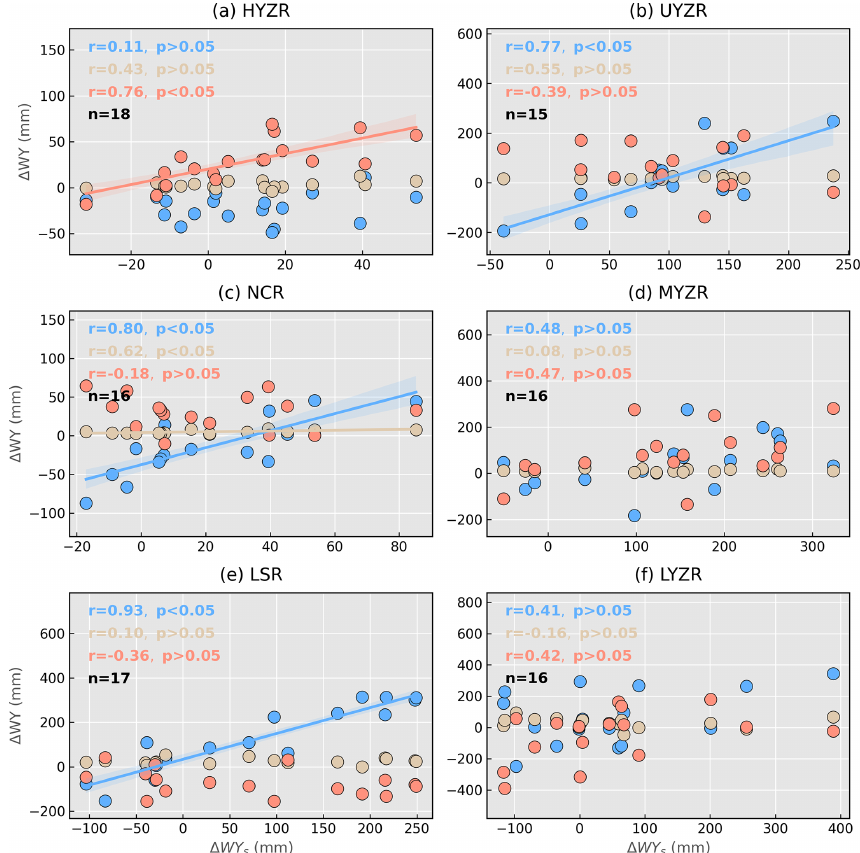
Figure 6. The correlation between the time series of total water yield deviation ( (cid:49) WY s (t) ; x axis) and its components ( y axis) caused by climate ( (cid:49) WY c (t) ; blue point), vegetation ( (cid:49) WY v (t) ; tan point), and cryosphere ( (cid:49) WY g (t) ; red point), respectively. The fitting line and its 95% confidence interval are shown only when the p value < 0.05. n indicates the number of years after Tp, which is determined by the Pettitt method (see Table 1 and Fig.